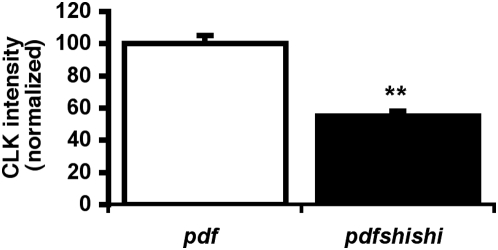
CLK levels are reduced in shibirets1-expressing sLNv.
pdfGAL4/+; Ushits1/ Ushits1 flies were entrained at 29°C. On DD3 (CT16), sLNv nuclear CLK levels were reduced to about 60% of control levels. (**p<0.05).